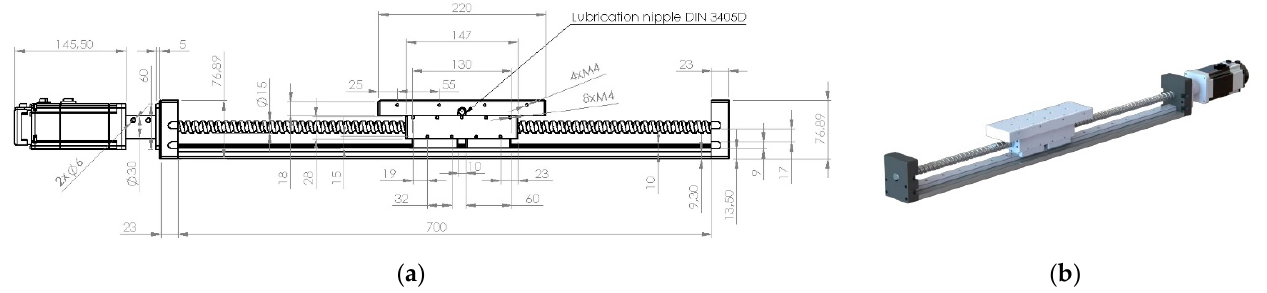
Figure 1. Linear servo axis with ball screw. ( a ) Technical drawing of the lateral view. ( b ) 3D view.